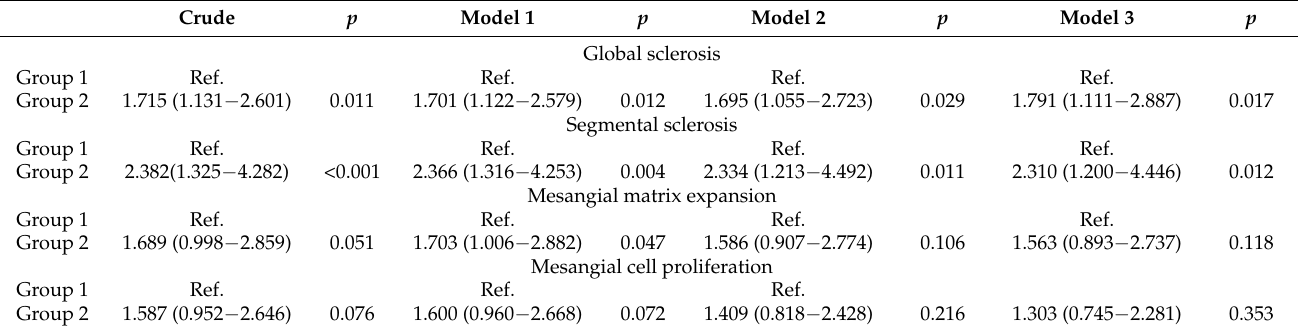
Table 7. Logistic regression analysis of TG groups and histopathologic parameters.